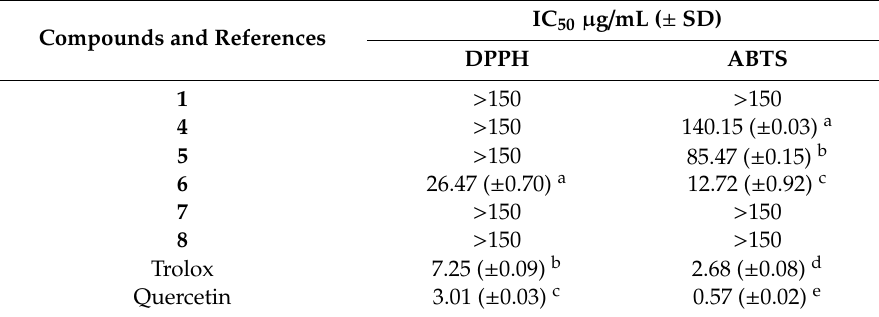
Table 1. Antioxidant activity of the synthesized compounds 1 , 4 – 8 .